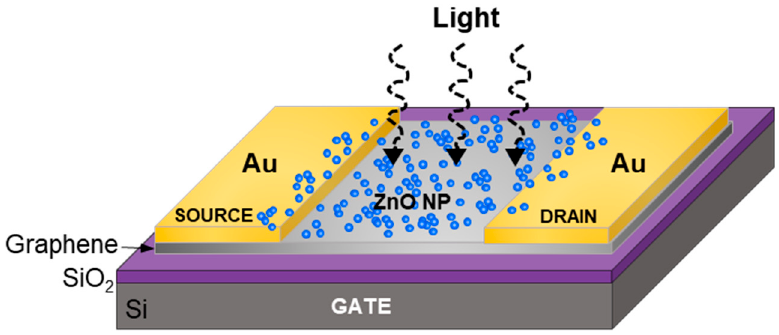
Figure 1. Schematic of the ZnO nanoparticle/graphene phototransistor architecture (not to scale).